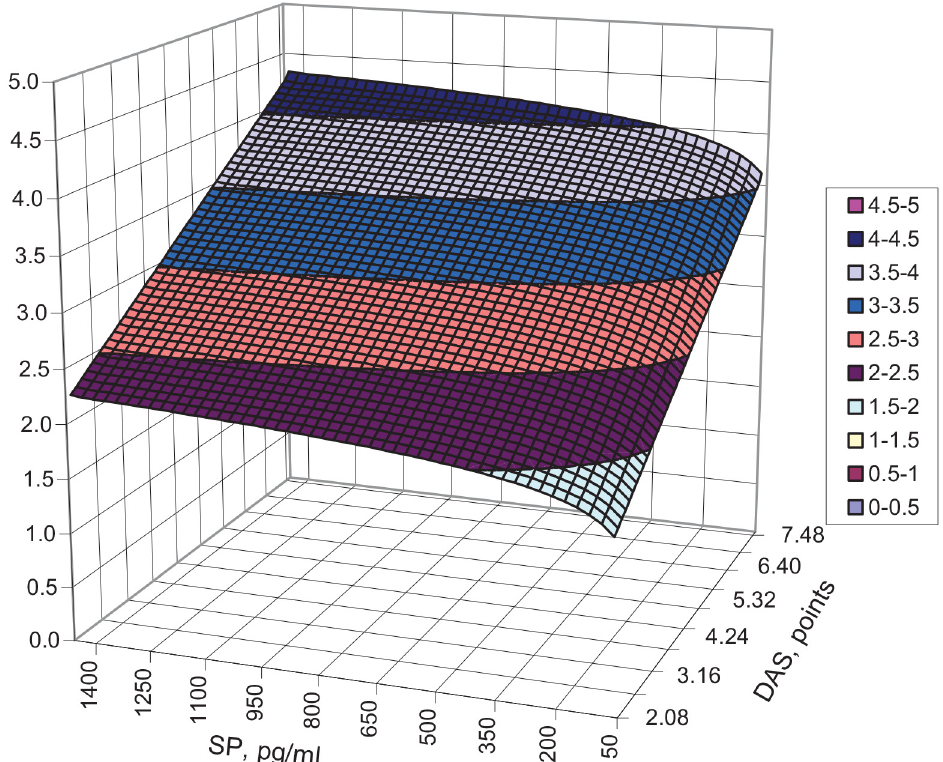
Fig 2. Interaction between the serum concentration of substance P (SP) and the disease activity (DAS) and intensity of pain (NPS) for patients with RA.